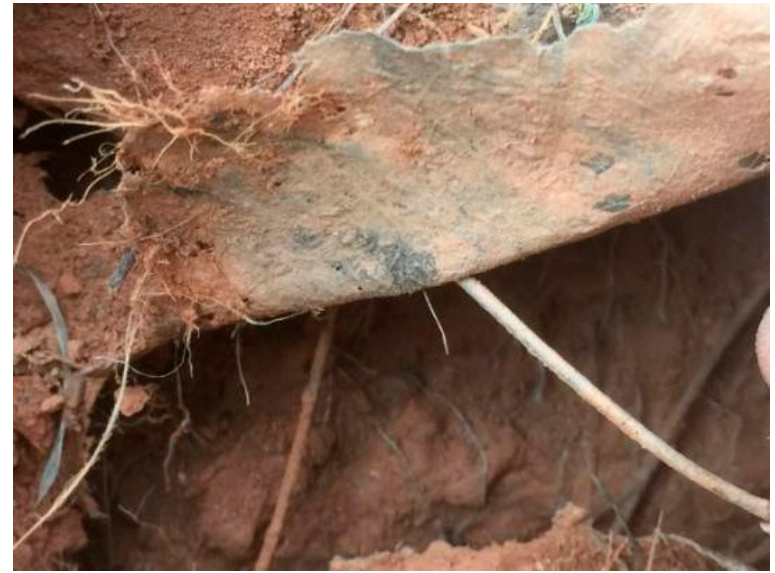
Figure 14. Penetration of the plant root system into the curing agent layer.